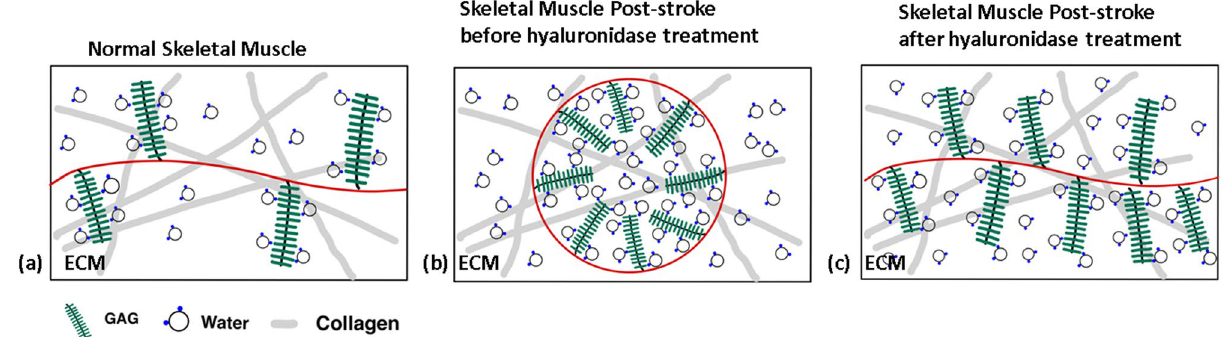
Figure 4. Schematic model of changes in GAG content and structure and its measurements with bi-exponential T 1ρ. ( a ) shows a cross-section of the molecular environment in normal skeletal muscle. T1ρ measures the chemical exchange between negatively charged GAG and protons in water. In ( b ), excessive GAG in stiff muscles undergoes a phase change, forming aggregates and trapping water in macromolecular spheres. The relative fraction of the short component increases due to GAG accumulation. T 1ρs is relatively unchanged as the chemical exchange is unchanged, but T 1ρl increases due to the trapped free water. In ( c ), treatment with hyaluronidase breaks down the GAG aggregates/ macromolecular spheres, with a shift in T 1ρ parameters to more normal